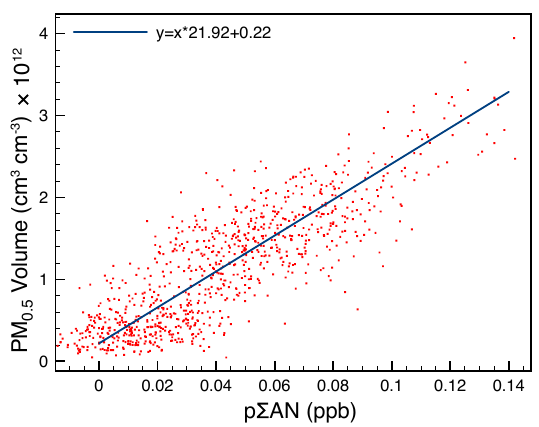
Figure 3. Correlation of PM 0 . 5 volume measured by SMPS to par- ticulate organic nitrate concentration ( R 2 =